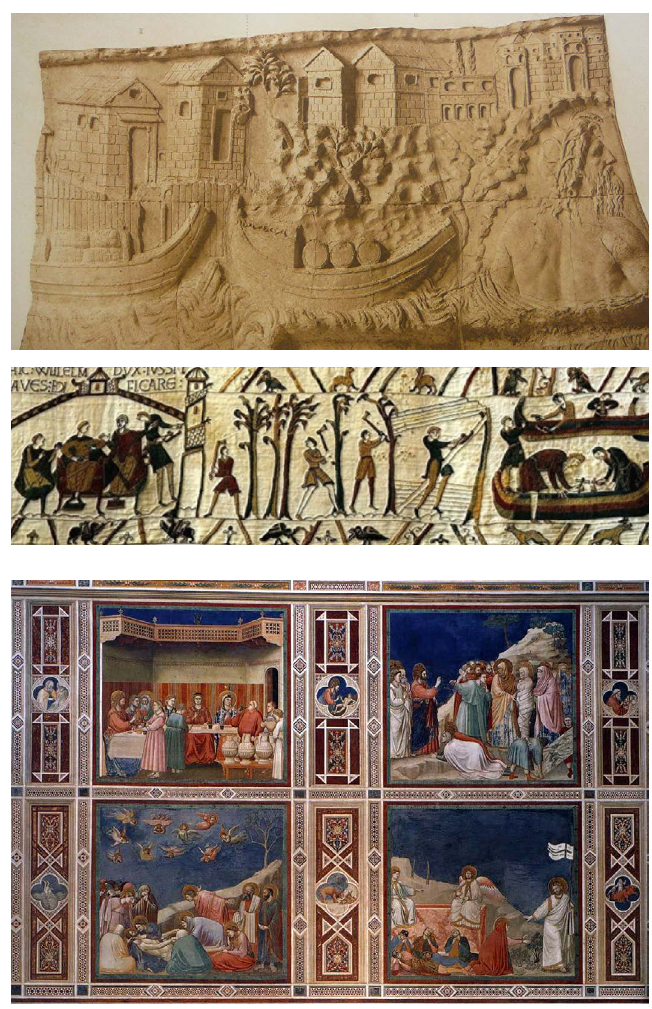
Fig. 4 Supplies on the Danube,